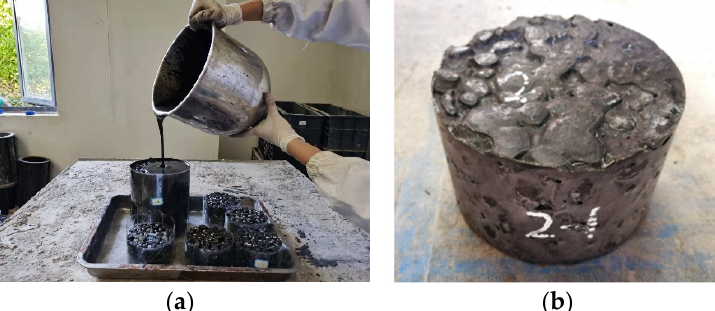
Figure 3. SFP specimen fabrication: ( a ) filling cement grout; ( b ) cured SFP specimen.